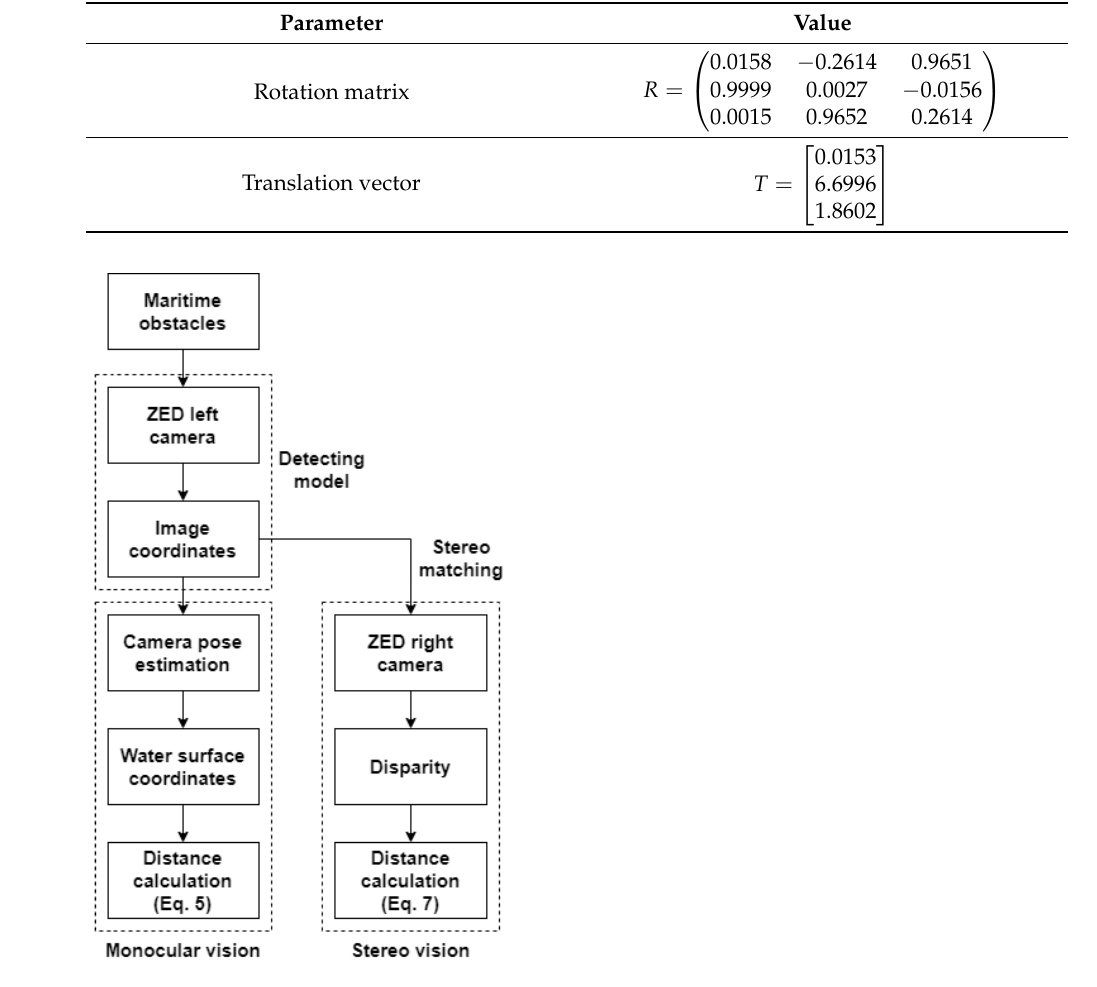
Figure 13. Summary of the experimental processing steps.